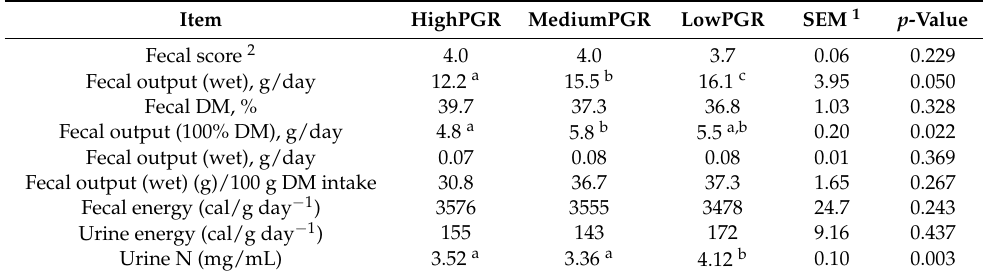
Table 2. Feces and urine characteristics of cats fed 3 experimental diets differing in perceived glycemic response